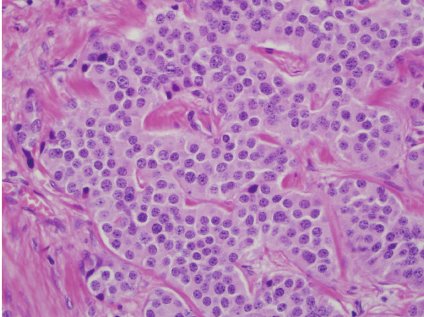
Figure 1: Low power view of neuroendocrine tumor within the sub- mucosa in the jejunum.